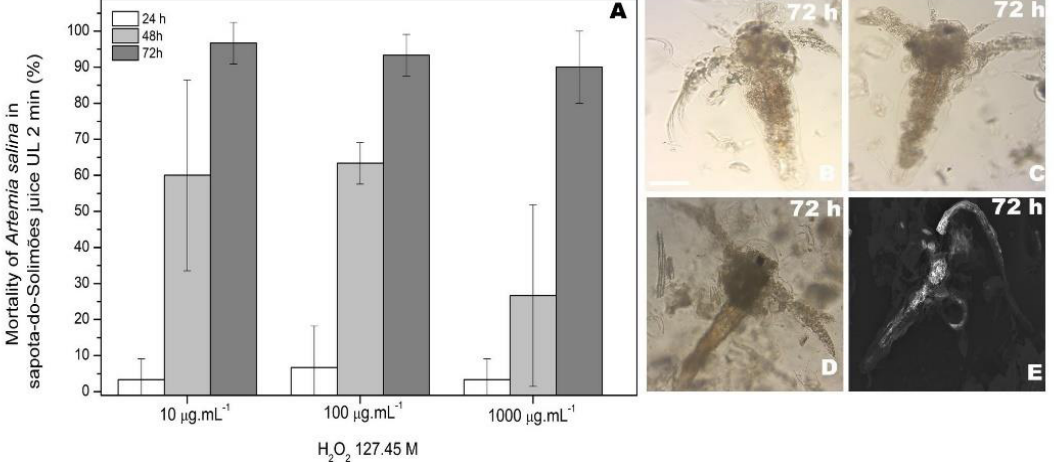
Figure 5. Protective effect of ultrasound-processed sapota-do-Solimões juice (UL2) in the 24/48/72 h interval against H 2 O 2 using Artemia salina nauplii ( A ) . Morphological changes in the Artemia salina nauplii after 72 h of exposure under optical microscopy ultrasound-processed sapota-do-Solimões juice 2 min (UL2) 10 µg·mL −1 ( B ), ultrasound-processed sapota-do-Solimões juice 2 min (UL2) 100 µg·mL −1 ( C ), ultrasound-processed sapota-do-Solimões juice 2 min (UL2) 1000 µg·mL −1 ( D ). Morphological changes in the Artemia salina nauplii by scanning electron microscopy ultrasound-processed sapota-do-Solimões juice 2 min (UL2) 1000 µg·mL −1 ( E ). Bars, 200 µm.